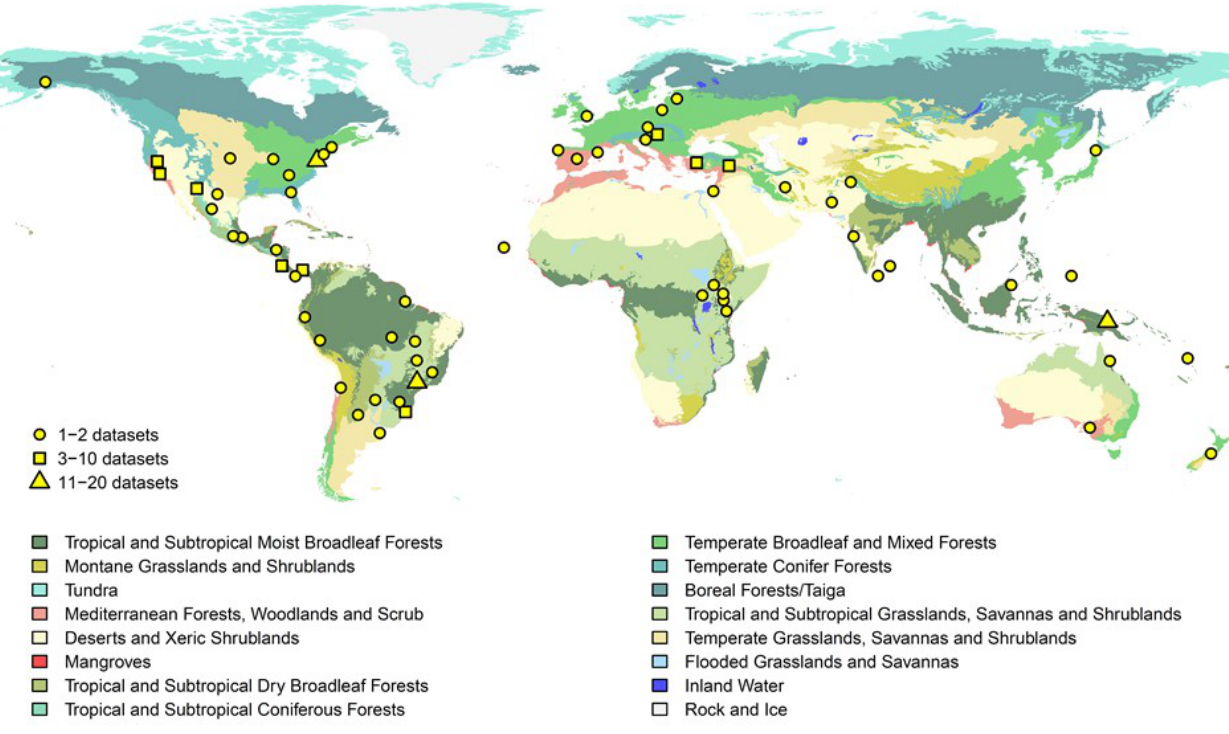
Figure 1. Global distribution of plant–herbivore datasets currently included in the LifeWebs database plotted in rela- tion to biomes (The Nature Conservancy). Note that where multiple points occupy similar coordinates, these have been separated slightly to aid